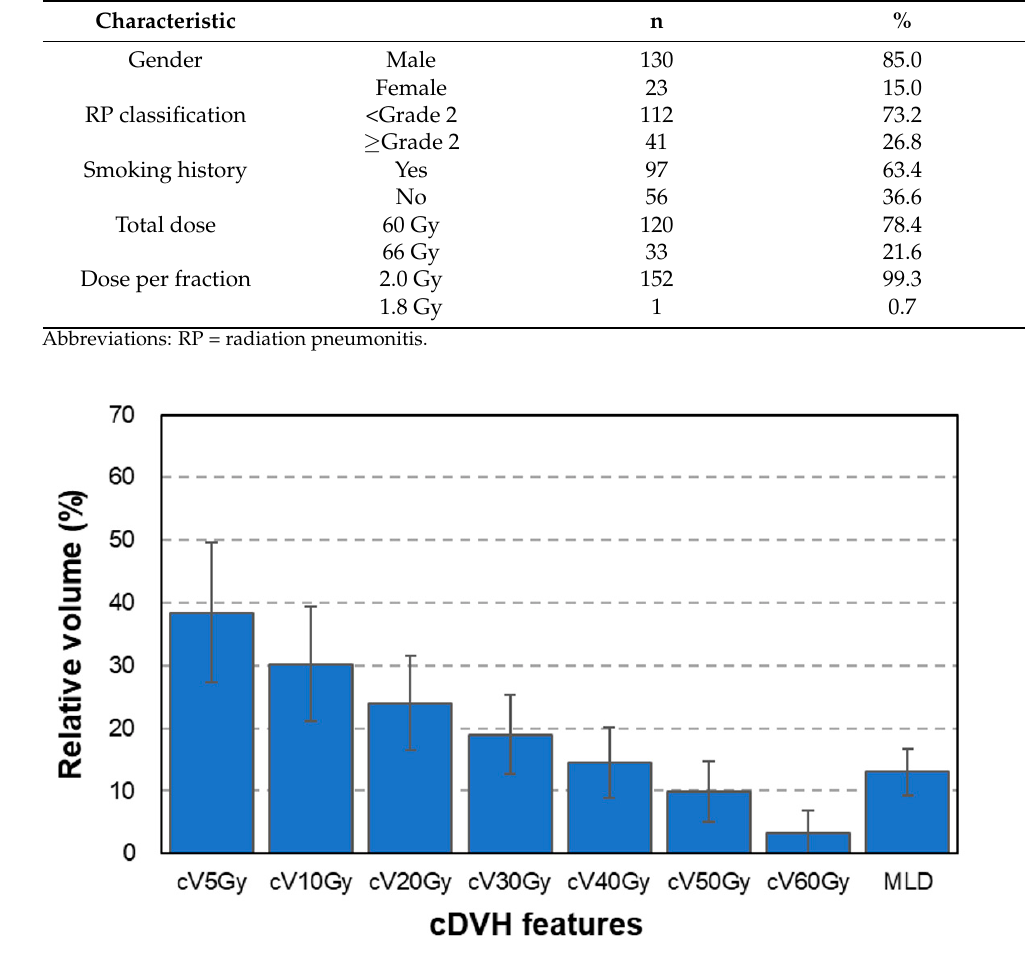
Figure 1. cDVH features of 153 patients in our cohort. Abbreviation: cDVH = cumulative dose–volume histogram. Data presented as mean ± standard deviation.